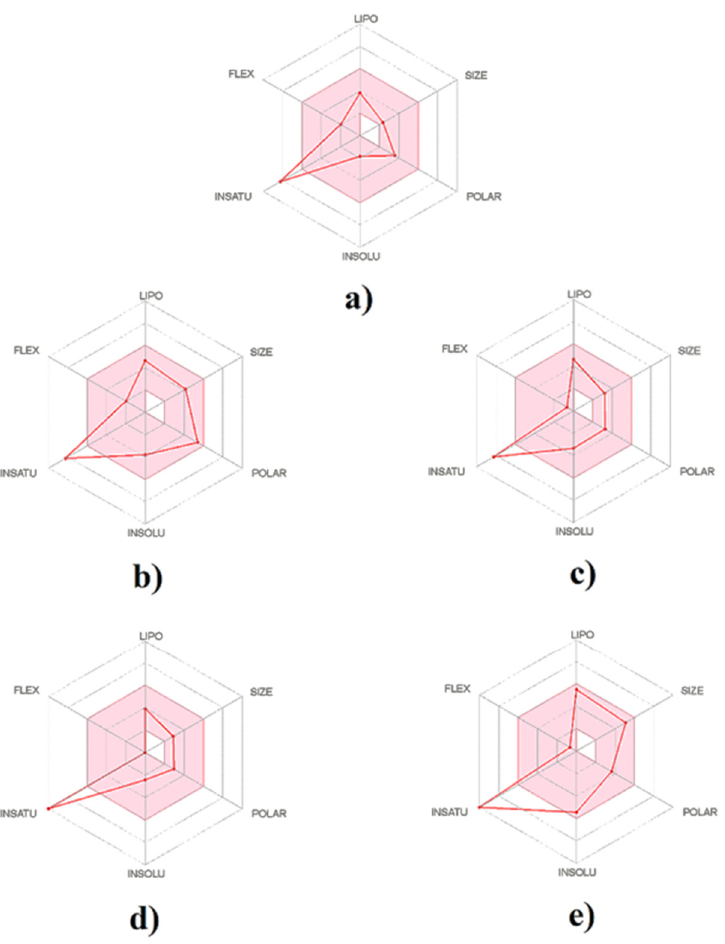
Figure 9. The bioavailability radar of brominated indole derivatives from Dicathais orbita compared to the NSAID control aspirin, generated using the SwissADME web tool: ( a ) aspirin, ( b ) tyrindoxyl sulfate, ( c ) tyrindoleninone, ( d ) 6-bromoisatin, and ( e ) 6,6’dibromoindirubin.